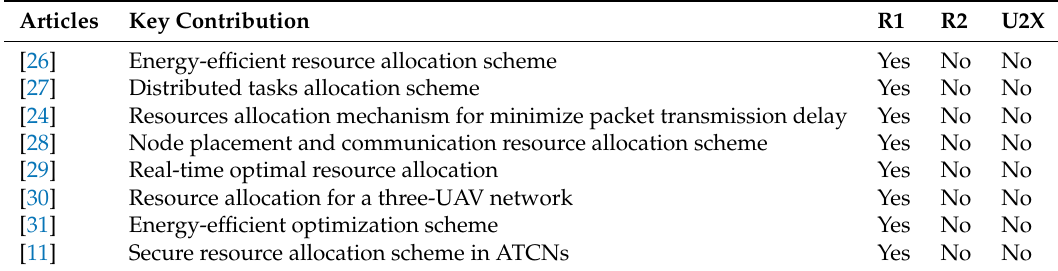
Table 1. Comparative summary of existing works. (R1: resource allocation, R2: backhaul). Articles Key